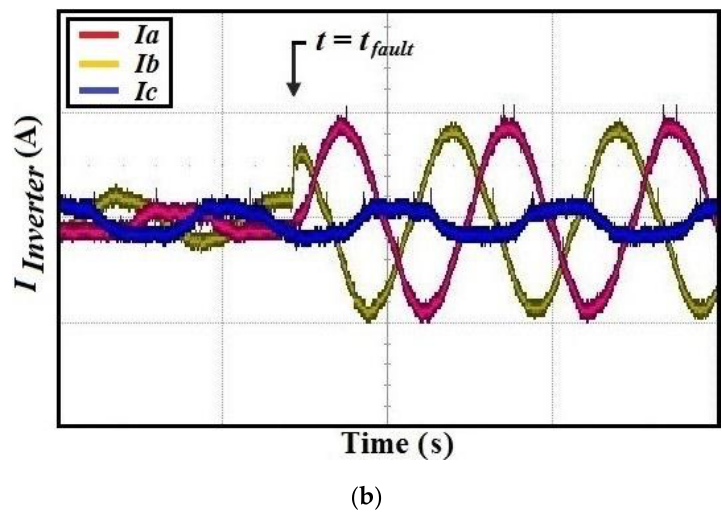
Figure 8. Experimental waveforms of inverter currents ( I Inverter ) with the proposed asymmetrical fault correction technique during: ( a ) S-L-G; ( b ) S-L-L; and D-L-G faults (X-axis: 20 ms/div; Y-axis: 1 A/div).